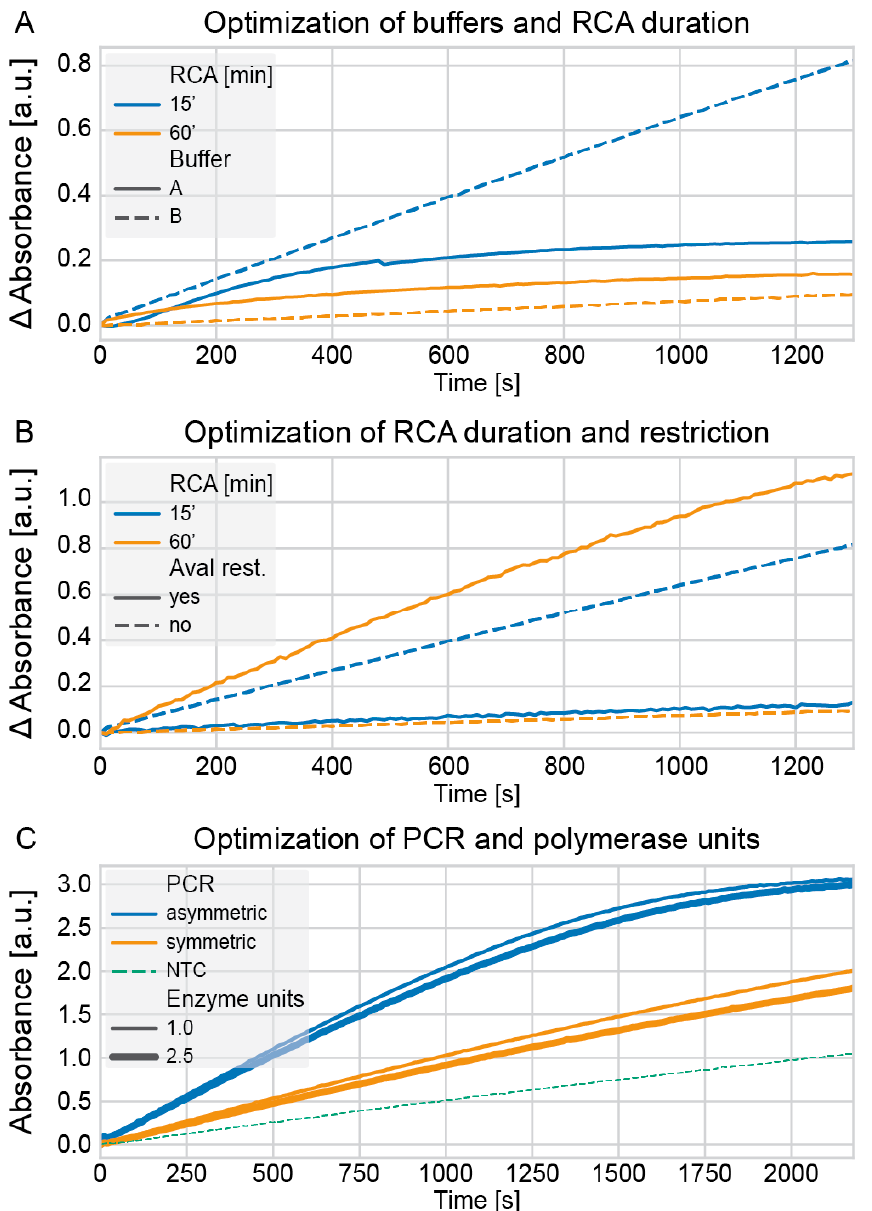
Figure 3. Optimization of the PCR, RCA, restriction, and detection buffer. The amplification and detection of the CTX-M-1 gene were used as a representative example. ( A ) The RCA was carried out for 15 or 60 min, and the detection was done in buffers of different compositions and pH. ( B ) The RCA was carried out for 15 or 60 min, and the RCA products were restricted by the addition of the AvaI restriction enzyme. ( C ) A symmetric PCR was compared to an asymmetric PCR, and the number of polymerase units was evaluated. In ( A , B ), the absorbance is normalized to the corresponding negative controls. In contrast, in C, the absolute absorbance is given, and the signal of the negative control is shown on the graph.